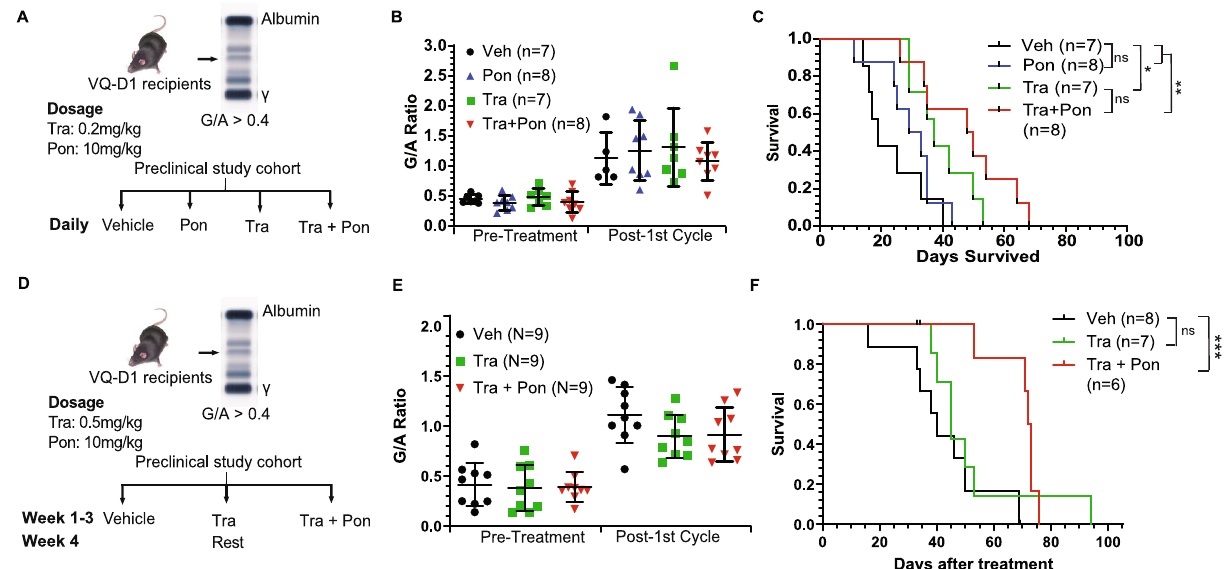
Figure 3. Combination trametinib and ponatinib treatment prolongs VQ myeloma survival. ( A ) Scheme of pre-clinical treatment groups and in vivo drug dosages. Mice were treated with the indicated compounds daily as described in Materials and Methods. ( B ) Serum protein electrophoresis was performed to quantify the γ-globulin/Albumin (G/A) ratios in VQ recipient mice before treatment and at day 21 of treatment. Note: Two Vehicle-treated recipients were found dead and unable to be analyzed. ( C ) Kaplan–Meier survival curves were plotted against days after treatment. Log-rank test was performed. ( D ) Scheme of pre-clinical treatment groups and in vivo drug dosages. Mice were treated with the indicated compounds in 28-day cycles (3-weeks on and one-week off) as described in Materials and Methods. ( E ) Serum protein electrophoresis was performed to quantify the G/A ratios in VQ recipient mice before treatment and at day 21 of treatment. Note: One Vehicle- treated recipient was found dead and unable to be analyzed. ( F ) Kaplan–Meier survival curves were plotted against days after treatment. Log-rank test was performed. Note: One vehicle-treated animal was euthanized for reasons unrelated to treatment study and was excluded from analysis. * p < 0.05; ** p < 0.01; *** p <